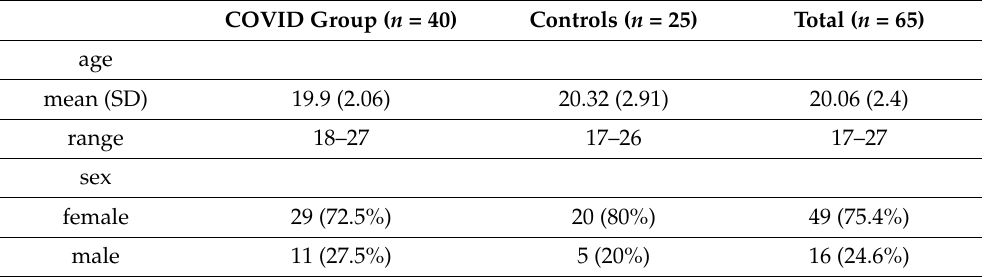
Table 1. Demographic characteristics by